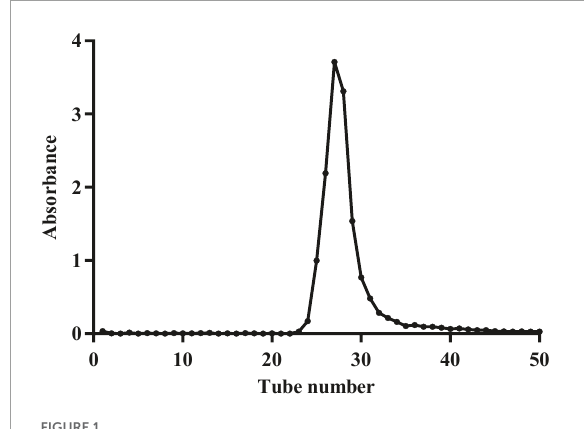
FIGURE1 Elution curve of crude polysaccharide from Sparassis latifolia on DEAE-52 cellulose